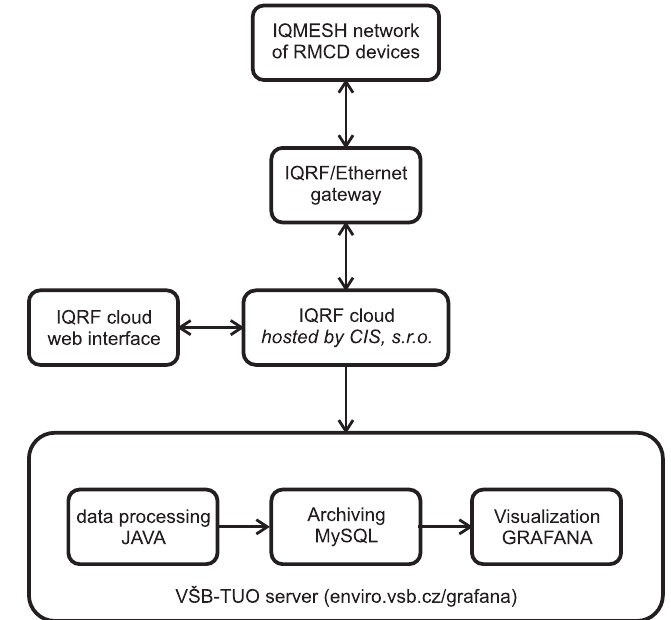
Figure 5. Scheme for processing, archiving, and visualizing measured data for case